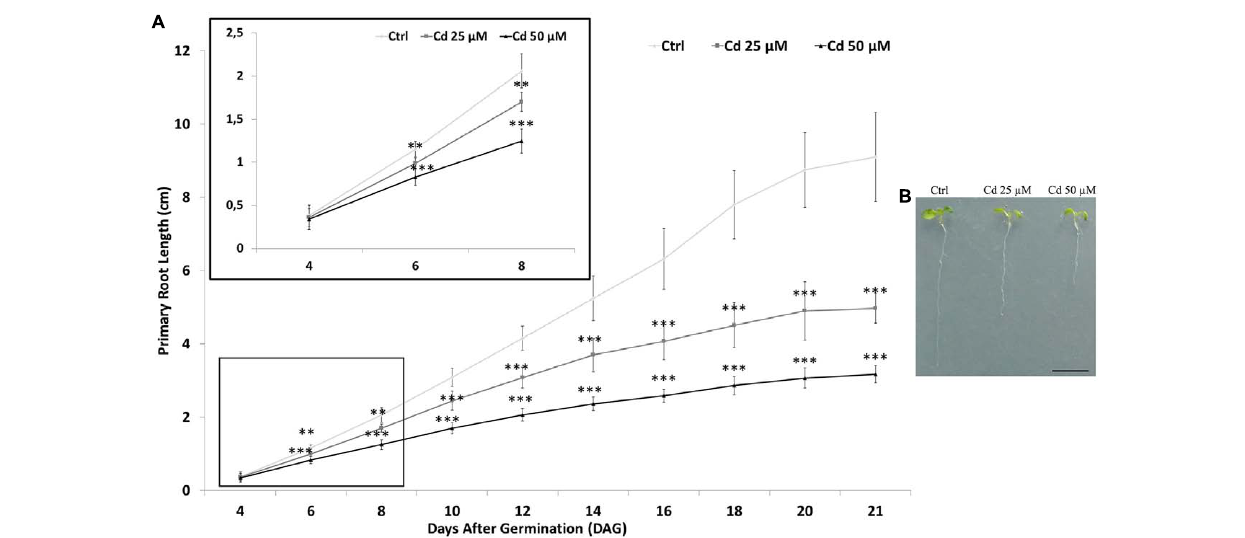
FIGURE 1 | (A) Root length of Arabidopsis thaliana seedlings germinated on growth medium as control (Ctrl) and on medium added with 25 or 50 µ M Cd for 21 days after germination (DAG). In the box, higher magnification of graph from 4 to 8 DAG is showed. (B) Picture of Ctrl and Cd-treated seedlings at 8 DAG. The results represent the mean value ( ± standard deviation) of three independent biological replicates. Asterisks indicate significant pairwise differences using Student’s t -test ( ∗ P < 0.05; ∗∗ P < 0.01; ∗∗∗ P < 0.001). Scale bar (B) 0.5 cm.